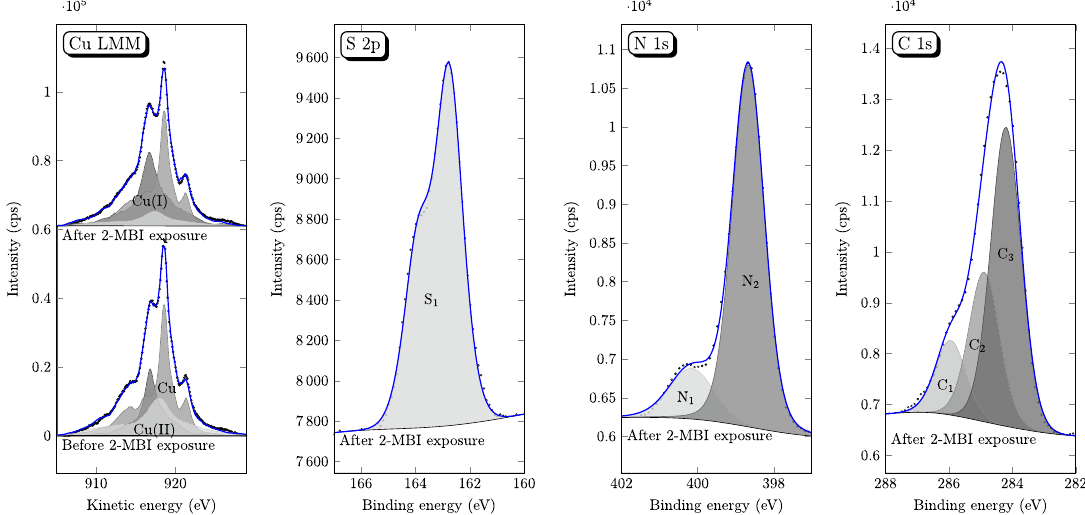
Fig. 6 High resolution XPS spectra obtained before and after 2-MBI exposure until saturation on Cu(111) pre-exposed to air (3D oxide) at 1 × 10 − 9 mbar of 2-MBI and RT. The Cu LMM Auger spectra before and after 2-MBI exposure and S 2p, N 1s and C 1s core levels after 2-MBI exposure.